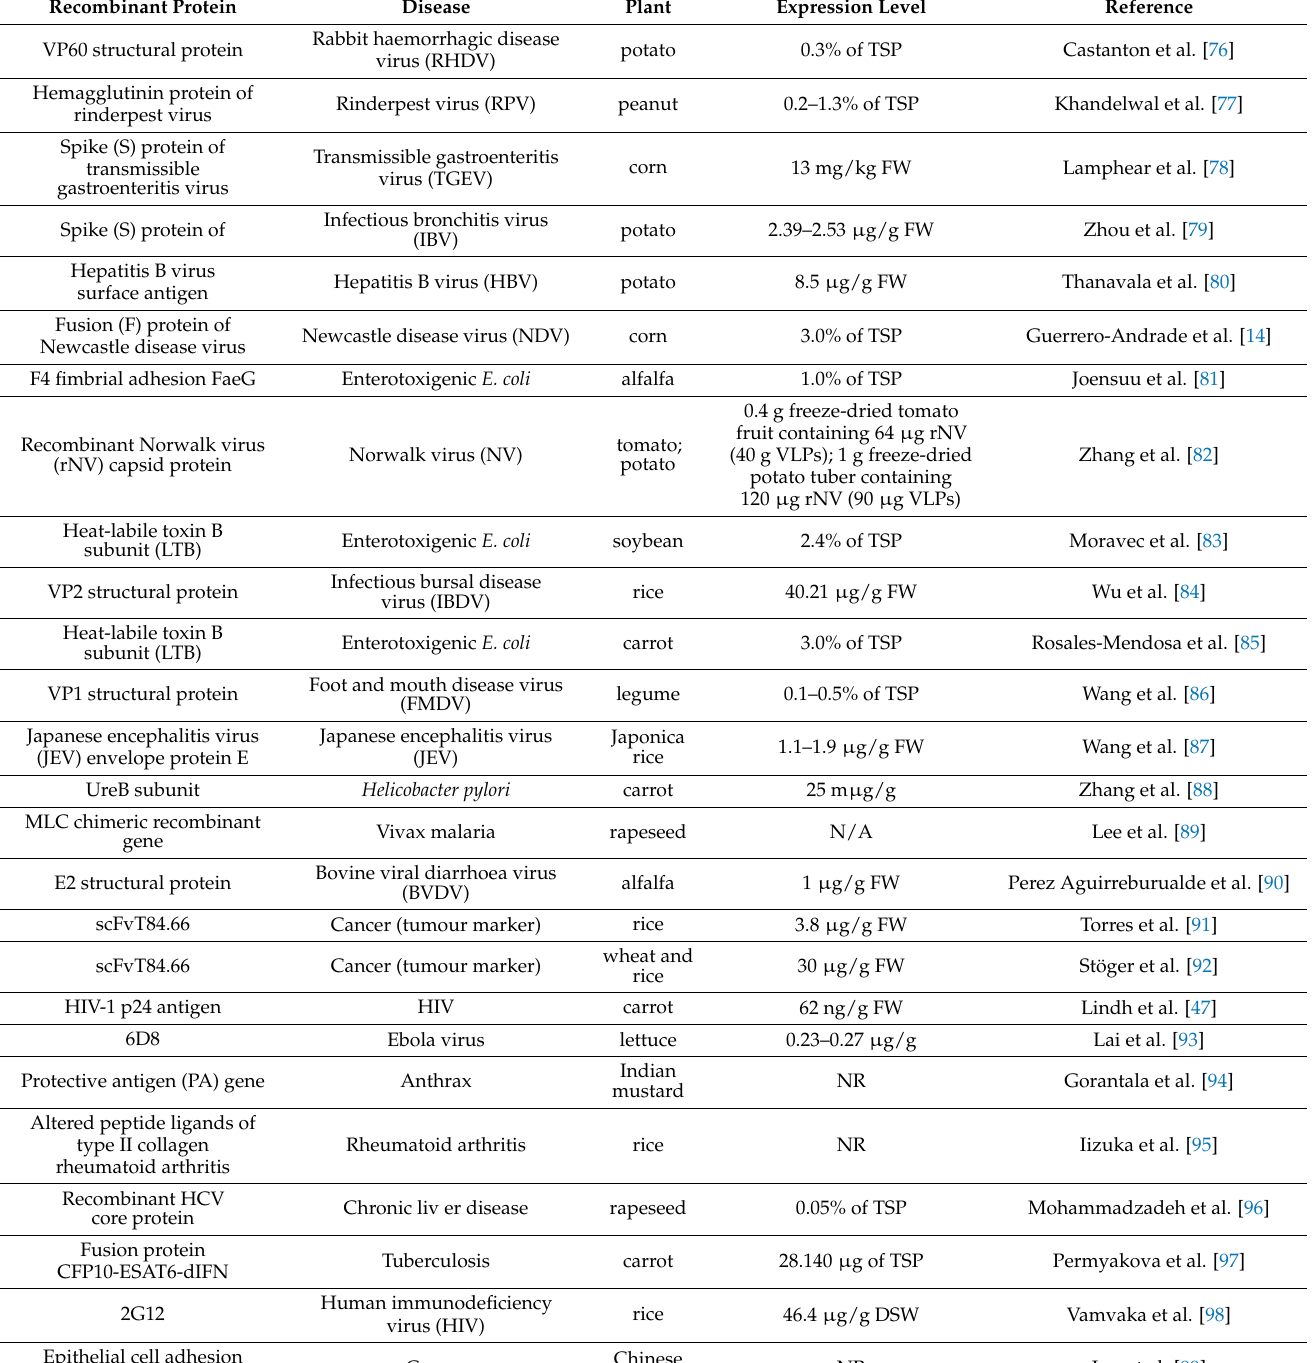
Table 2. Selected therapeutic proteins (potential vaccine candidates and antibodies) produced in edible crop